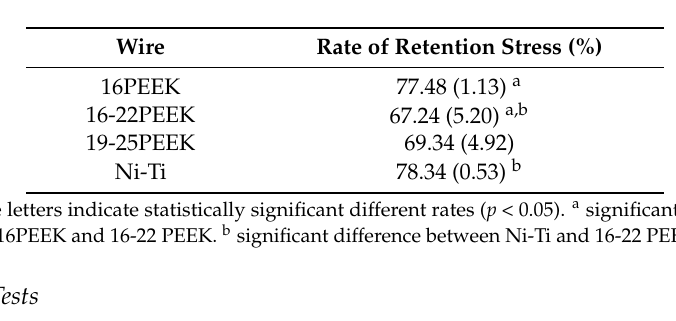
Figure 5. Rate of retention stress ( a ) rate of retention stress of 16 PEEK (Polyetheretherketone); ( b ) rate of retention stress of 16-22PEEK; ( c ) rate of retention stress of 19-25PEEK; ( d ) rate of retention stress of Ni-Ti. Table 1. Rate of retention stress after 24 h. Values are given as mean (SD). Table 1. Rate of retention stress after 24 h. Values are given as mean (SD).